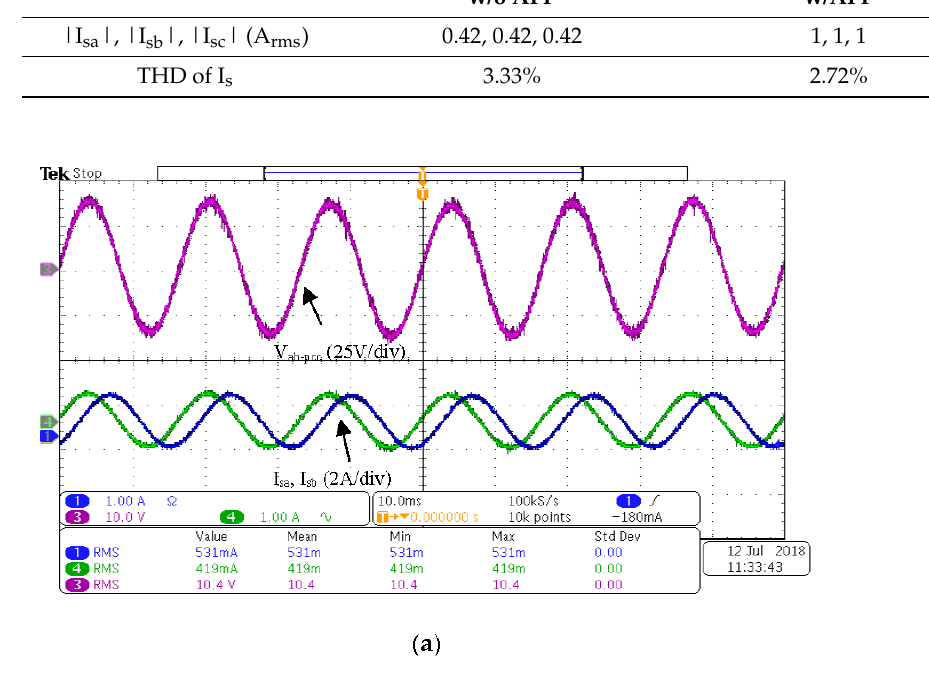
Table 7. Magnitudes and THD of the source currents.